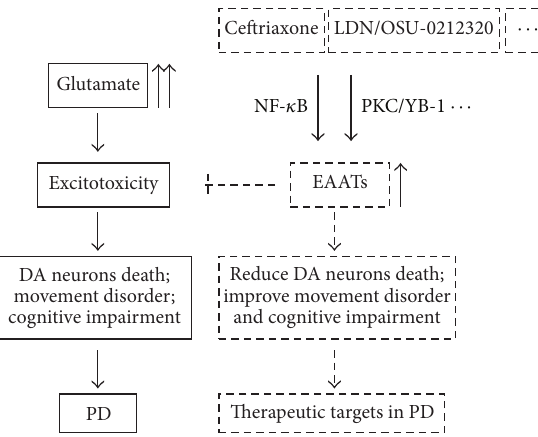
Figure 2: EAATs are therapeutic targets in PD. Excessive glutamate in the synaptic cleft overstimulates glutamate receptors in the postsynaptic membrane and mediates excitotoxicity. Glutamate excitotoxicity can induce the dopamine neurons death, movement disorder, and cognitive impairment, and thus it contributes to the pathogenesis of PD. Through upregulation of EAATs, ceftriaxone, LDN/OSU-0212320, and other drugs can reduce the DA neuron death in SNpc and striatum, improve the movement disorder and cognitive impairment in PD, and thus improve the PD progression. Thus, EAATs are therapeutic targets in